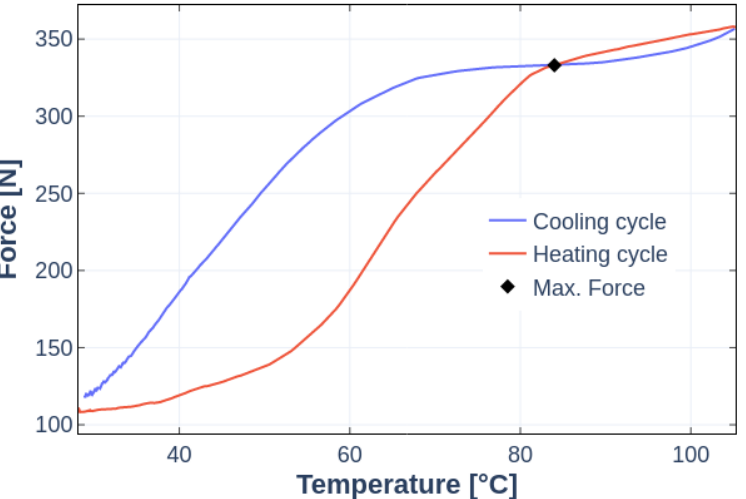
Figure 9. Typical force vs. temperature response for the ZFSMALA with a 30-wire